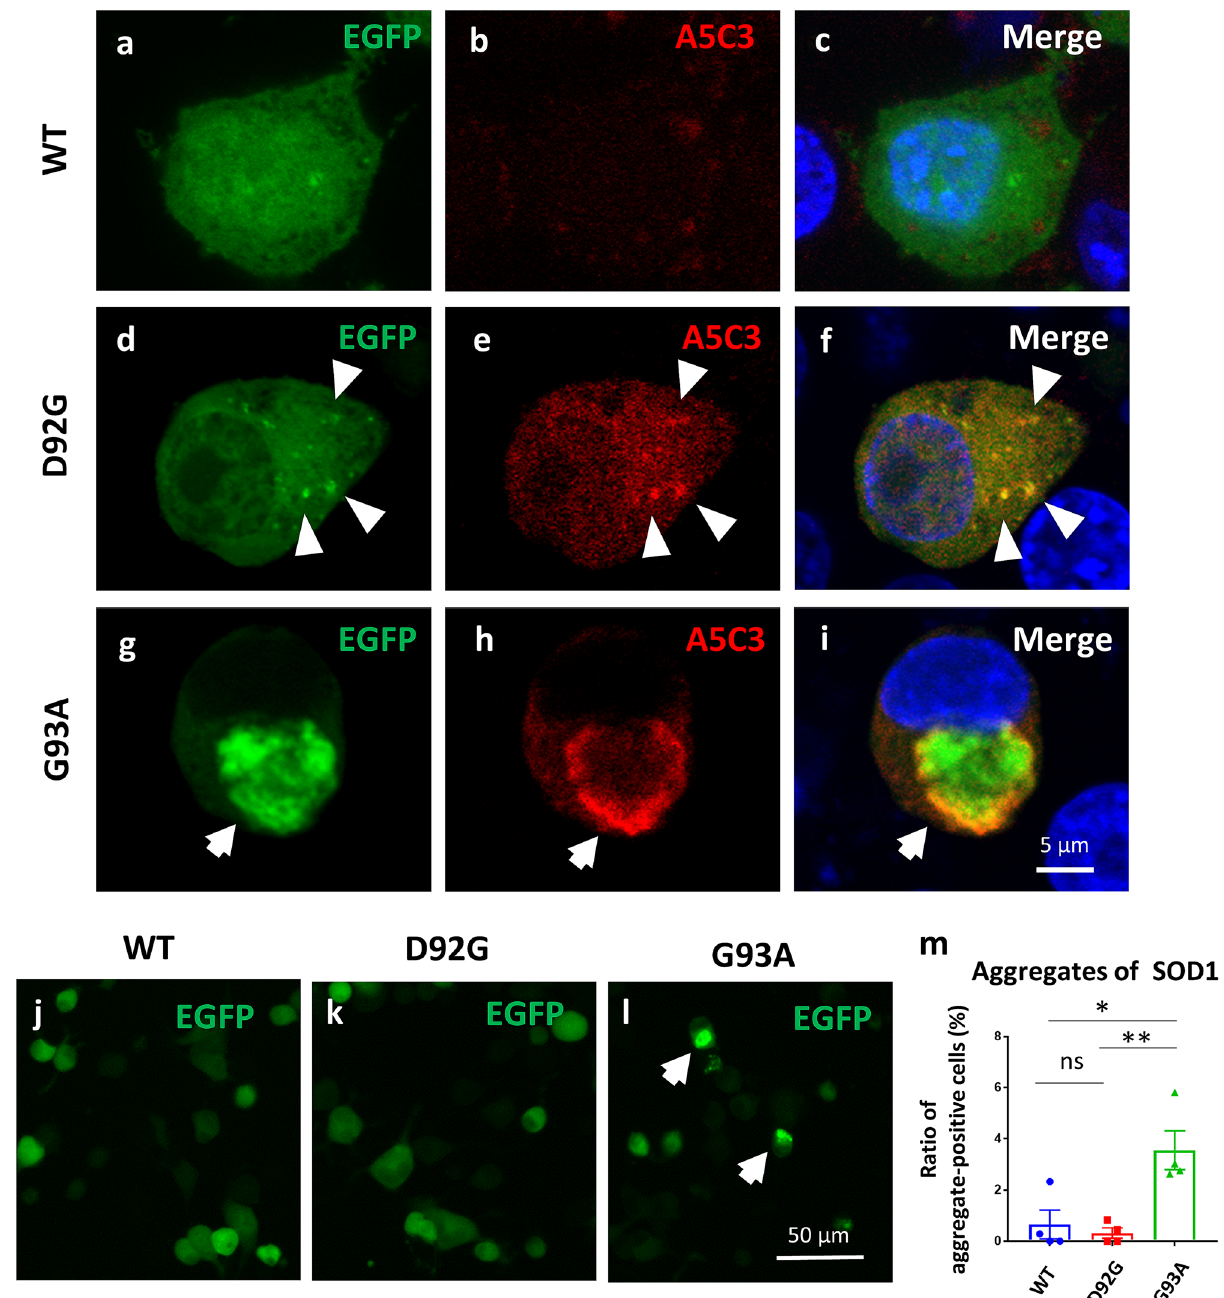
Figure 2. Analysis of aggregates of mutant SOD1. ( a – i ) Confocal microscopy images of SOD1-EGFP with immunostaining of misfolded SOD1. ( a – c ) SOD1-WT-EGFP (green) and misfolded SOD1 (A5C3, red). ( d – f ) SOD1-D92G-EGFP (green) and misfolded SOD1 (A5C3, red). Fine aggregates are observed in cells expressing SOD1-D92G-EGFP, which are immunostained with misfolded SOD1 antibody (arrow heads). ( g – i ) SOD1- G93A-EGFP (green) and misfolded SOD1 (A5C3, red). Round aggregates are observed in cells expressing SOD1-G93A-EGFP, which is immunostained with misfolded SOD1 antibody (arrows). Scale bar 5 µm. ( j – l ) There are no dense aggregates in cells expressing SOD1-WT/D92G-EGFP, whereas cells expressing SOD1- G93A-EGFP exhibit dense round aggregates. ( m ) Cells expressing SOD1-G93A-EGFP have significantly more dense round aggregates than cells expressing SOD1-WT/D92G-EGFP (p < 0.01) (n = 4). Scale bar 50 µm. Data are shown as means ± SD. One-way ANOVA (followed by Tukey’s test) is used for statistical analysis. *p < 0.05, **p <